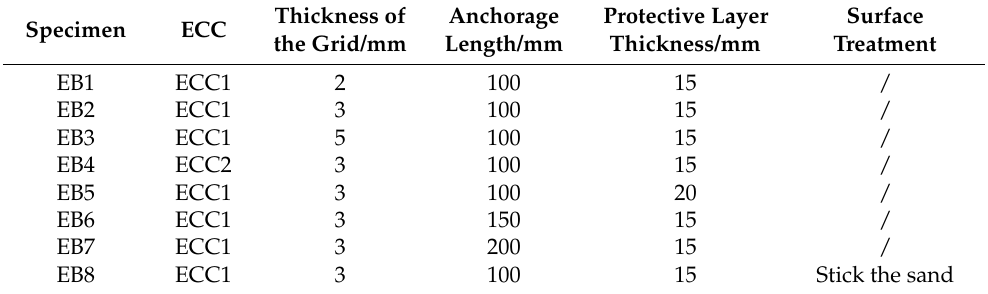
Table 4. Specimen